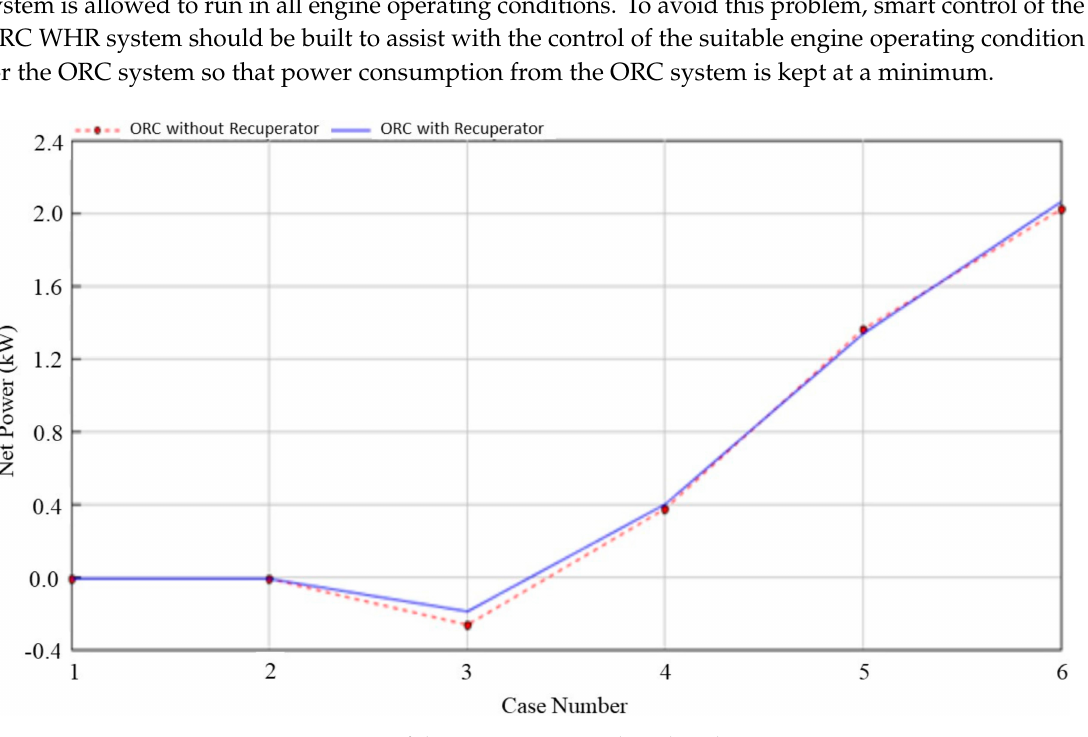
Figure 22. Comparison of the ORC System with and Without a